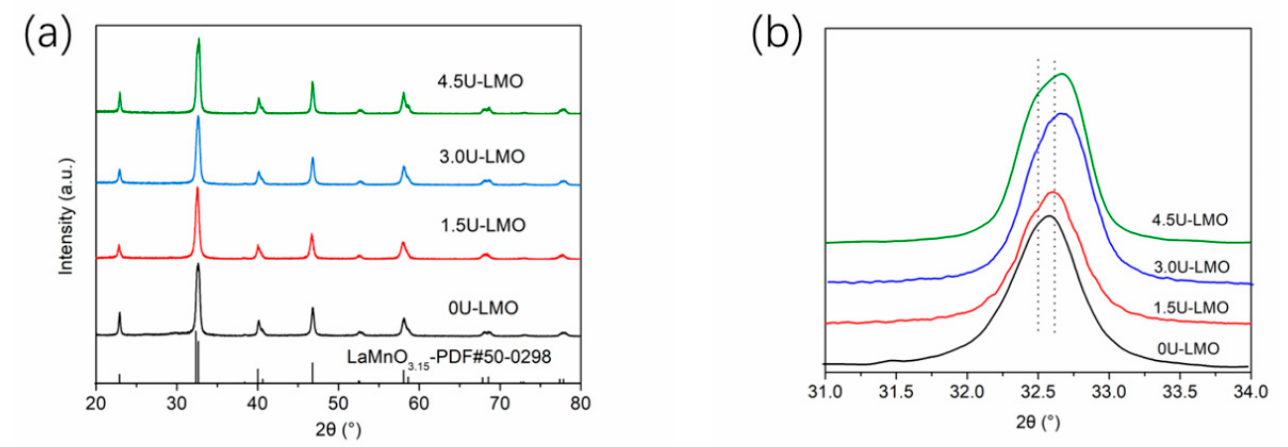
Figure 2. ( a ) XRD patterns of xU-LMO (x = 0, 1.5, 3.0, and 4.5) perovskite oxides and ( b ) main peaks at around 2 θ = 32.5–32.7 o (data below the patterns are from JCPDS file with a number of 50-0298). Table 1. The obtained values with Rietveld refinement method from XRD patterns.